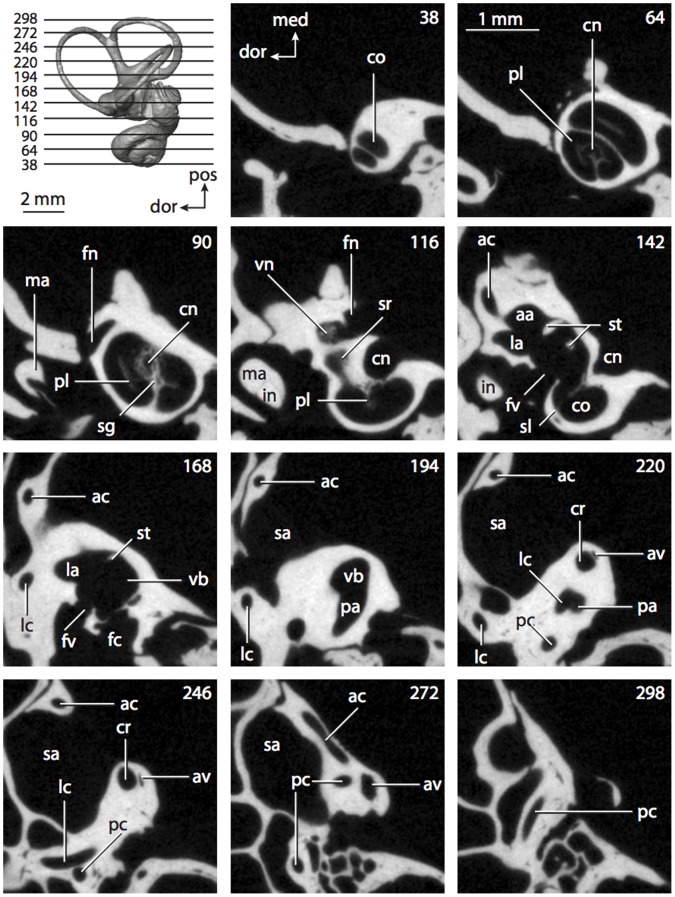
CT slices through ear region ofCynocephalus volans.Abbreviations listed at the end of the Materials and Methods section.